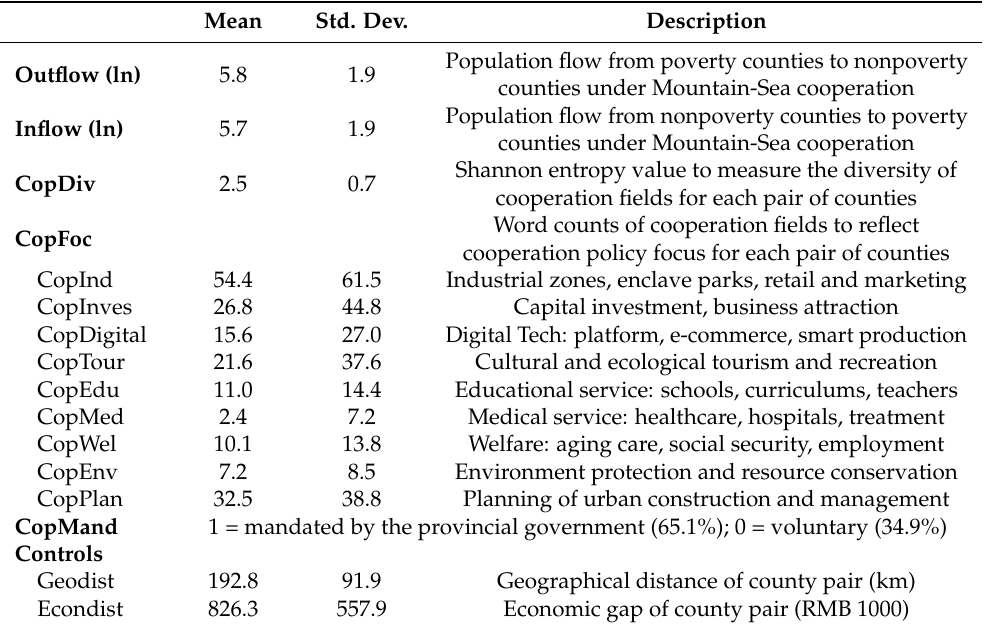
Table 1. Model variables for the county pair under the Mountain-Sea cooperation.